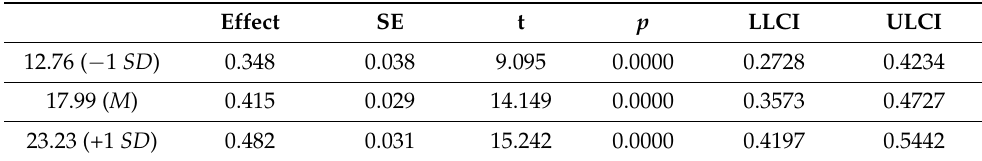
Table 4. Conditional effects of positive religious coping as a moderator for relationship between God’s support and life satisfaction.